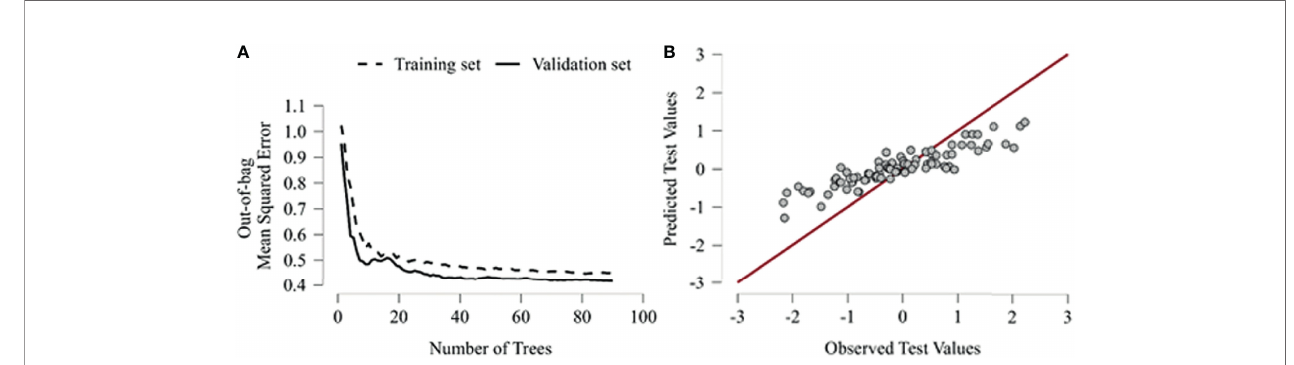
FIGURE 1 | (A) Out-of-bag accuracy plots the number of trees against the out-of-bag classi fi cation accuracy of the model. The accuracy is evaluated for the training and validation set, as the number of trees generated on the x-axis increases, it is evaluated how the error growths. (B) Predictive performance shows the selected test set observations against their predicted values. Thus, the graph analyzes through a hypothetical linear regression how the observed and predicted